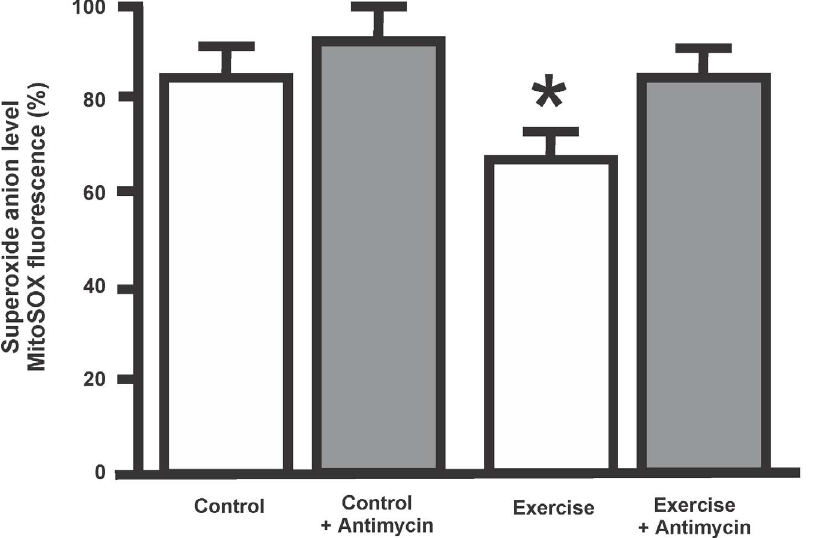
Figure 3. Determination of superoxide anion level. Mitochondrial samples were loaded with the superoxide anion sensor MitoSox during 20 min at 37 u C. Antimycin A (0.5 m M) was used as a positive control. Bar graph quantification of Mitosox fluorescence expressed as percentage values of human placental mitochondria from control and exercised women. Antimycin effect is also shown for both samples. Data are expressed as mean 6 SEM, from three independent experiments. (*p , 0.05, as compared with control value).